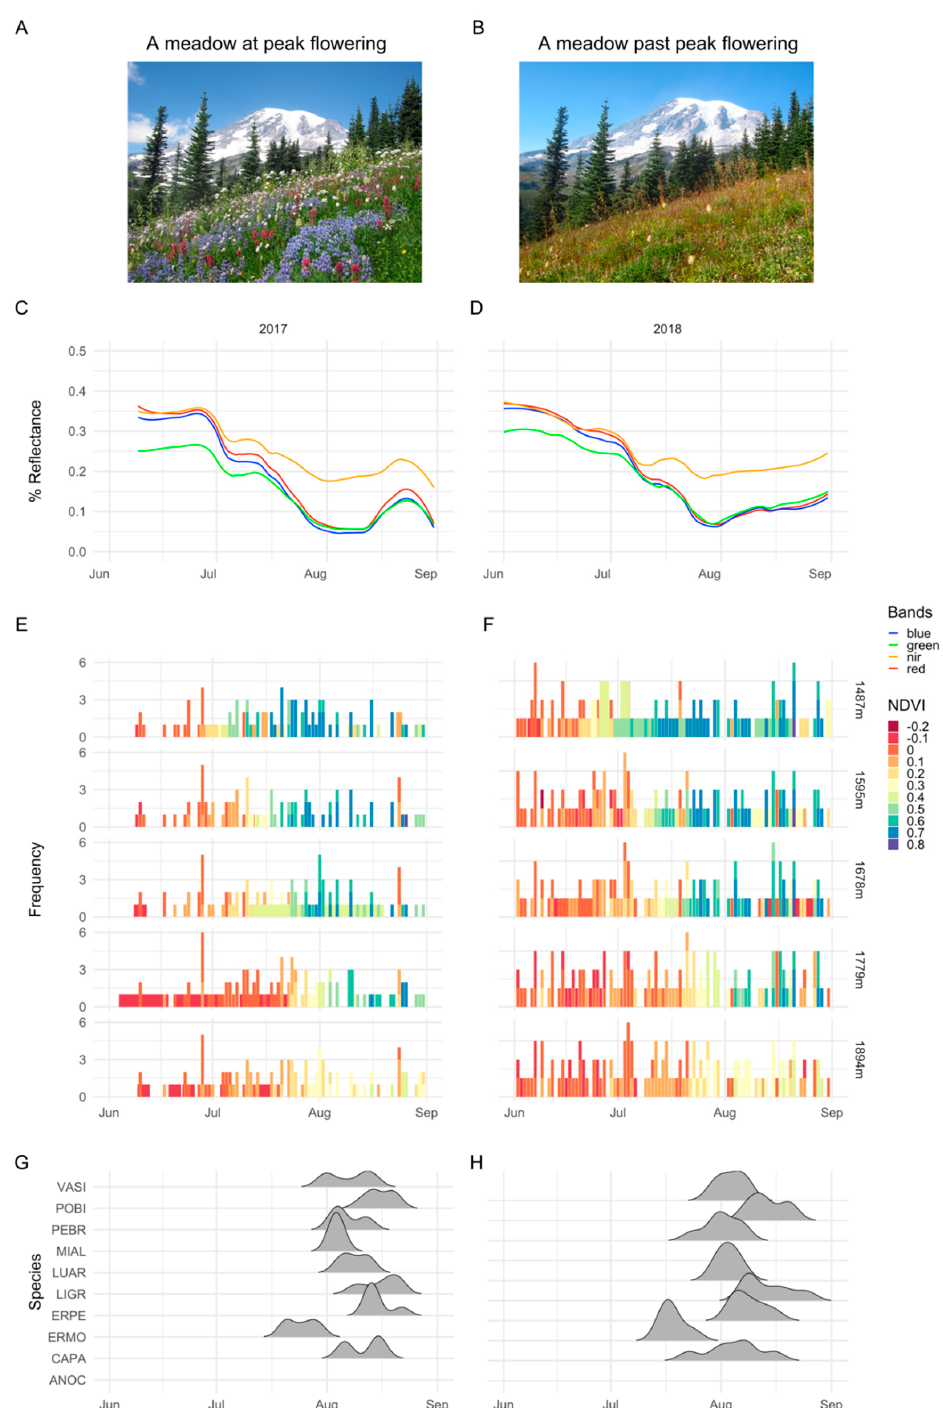
Figure 4. ( A , B ) A typical flowering meadow at peak, and a meadow past the peak flowering. ( C , D ) Reflectance profile of all the meadows across two years (2017 and 2018) using PlanetScope item PSScene4Band (type analytic_sr ) in the Planet workflow (PS). ( E , F ) Normalized Difference Vegetation Index (NDVI) profile of all the meadow sites by elevation for two years (2017, 2018) using PS. On the alternate y-axis is the elevation in meters, and y-axis shows the number of PS captures / meadow having the corresponding NDVI threshold. The NDVI thresholds are determined by taking the average of NDVI metric across the entire meadow. ( G , H ) Flowering observations for years 2017 and 2018 from MeadoWatch; showing dominant 10 flowering